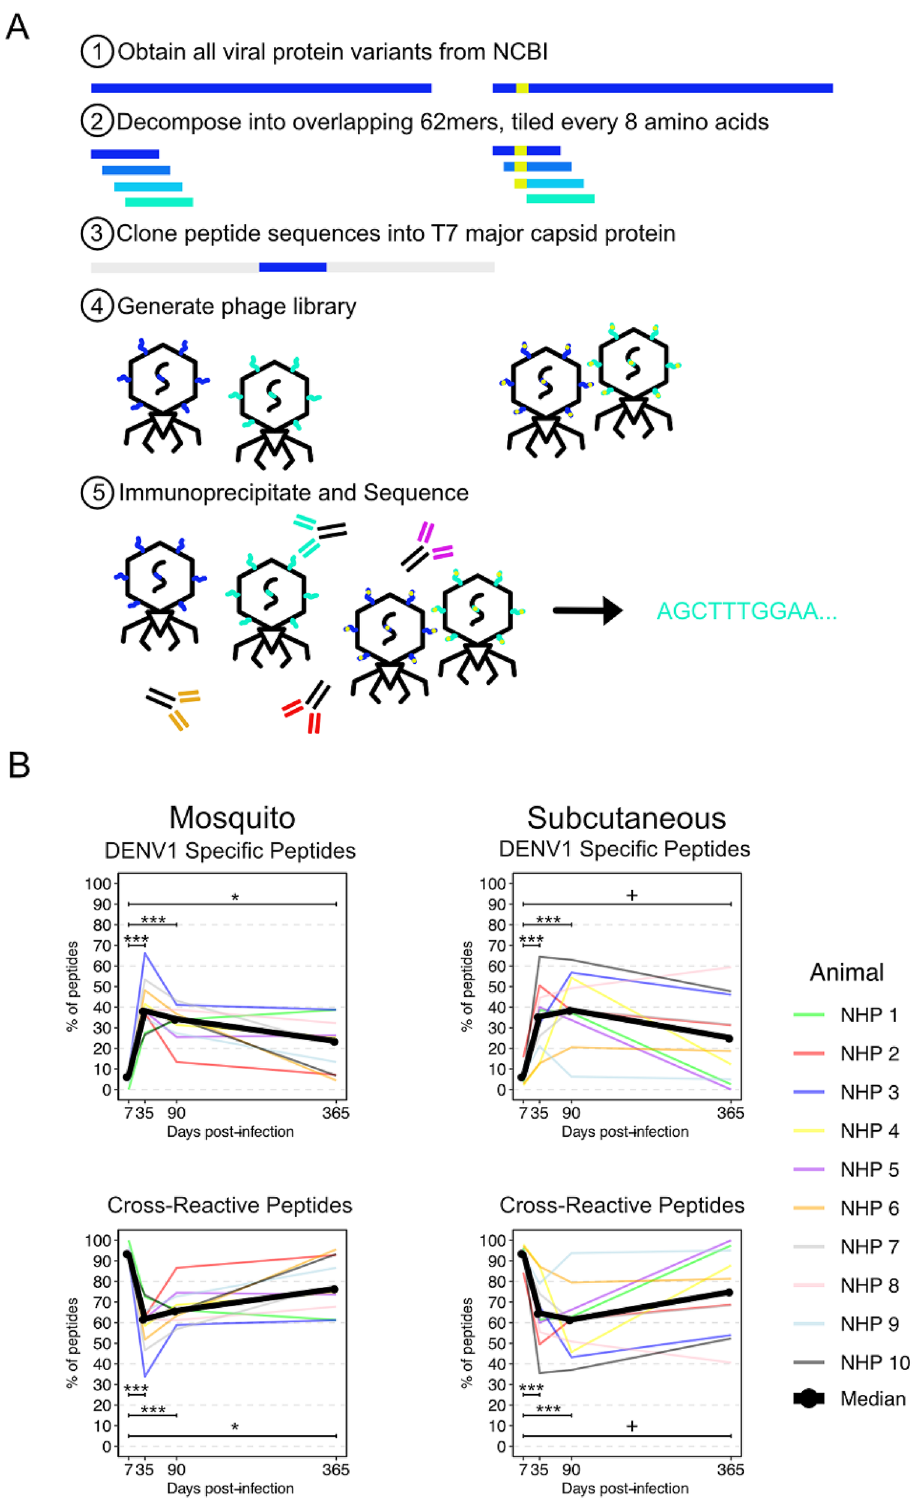
Figure 1. Phage display measurement of total sero-reactivity to dengue virus is similar in non-human primates infected by mosquito and subcutaneous infection. A redundant, densely tiled set of peptides encompassing 74 flaviviruses reported to infect humans was designed, validated and used for phage immunoprecipitation sequencing ( B ). Animal to animal signal variability was high in both the mosquito-infected (N = 10 animals) and subcutaneously infected (N = 10 animals) groups. DENV1 specific median sero-reactivity (> 90% similar to DENV1 only) in both groups was increased at 35, 90 and 365 days post-infection (*** p < 0.001; * p < 0.05; + p < 0.1) compared to 7 days post-infection. Cross-reactive median sero-reactivity declined in both groups as DENV1-specific sero-reactivity